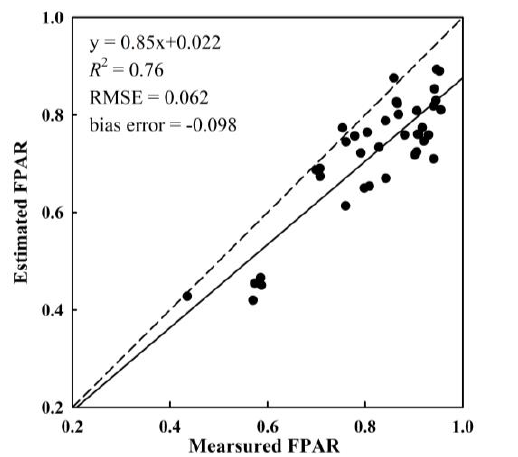
Figure 4. Comparison of the estimated FPAR and the field- measured FPAR ( n =